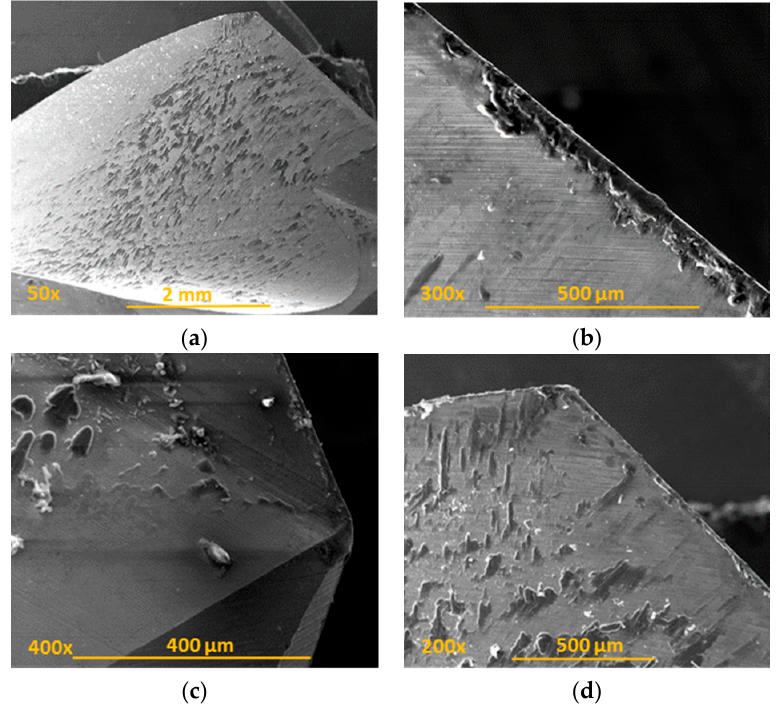
Figure 12. Wear located on the tool after conventional drilling of the CFRP/UNS A97075 stack: ( a ) Flute (BUL); ( b ) cutting lip (BUE y BUL); ( c ) tool tip; ( d ) joining of primary and secondary cutting edges (BUL).